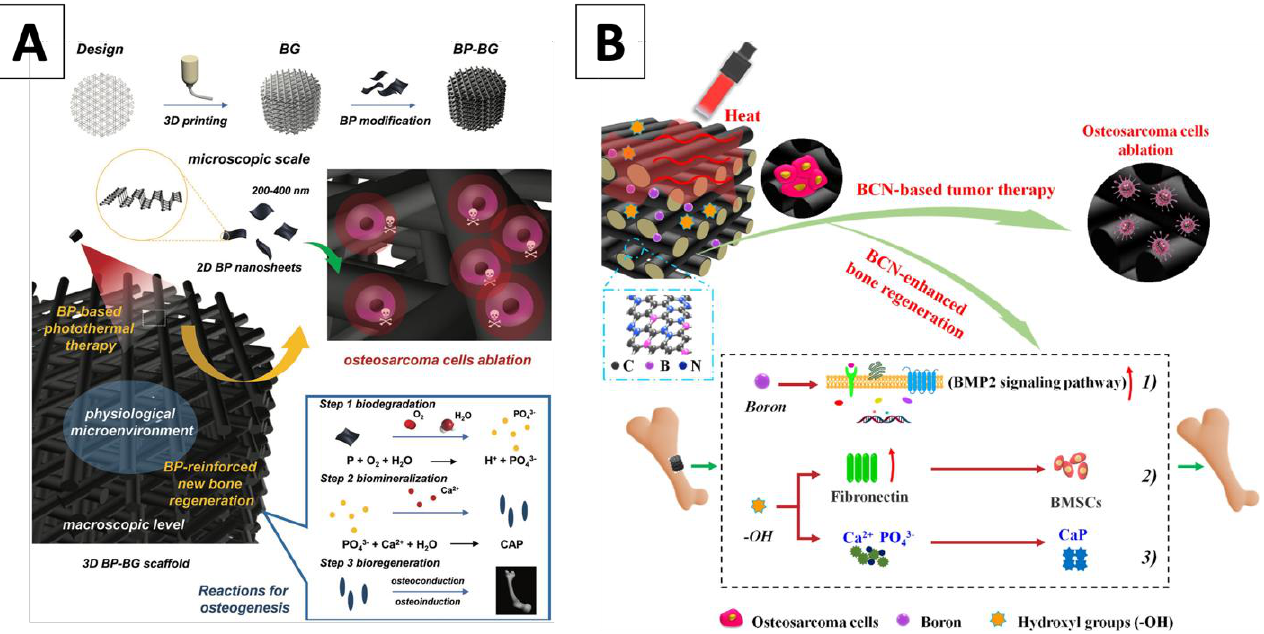
Figure 1. ( A ) Illustration of the fabrication process for BP-BG scaffold, highlighting the therapeutic strategy around the use of the scaffold for the successful removal of osteosarcoma, which was followed by osteogenesis through three steps: biodegradation, biomineralization and bioregeneration (Yang 2018) ( B ) Schematic showing the integrated strategy of BCN- AKT scaffolds for triggering photothermal therapy and repair of tumor-initiated bone defects (Zhaoa 2020). Abbreviations: BP nanosheets combined with 3D printed bioglass (BP-BG); 2D borocarbonitrides nanosheets combined with akermanite in a 3D bioglass (BCN-AKT).